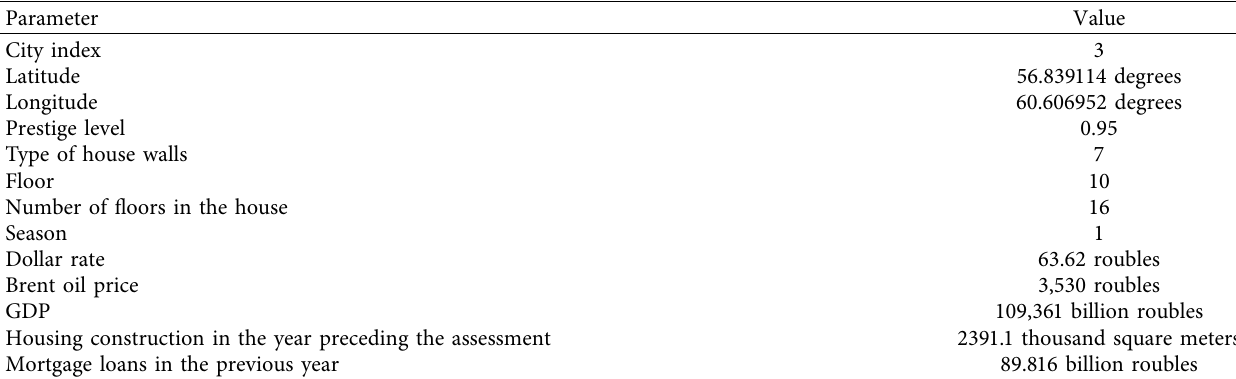
Table 4: Input parameters of the model that characterize a house in Yekaterinburg, its geographical location, evaluation time, and the corresponding economic situation in the world, country, and region.